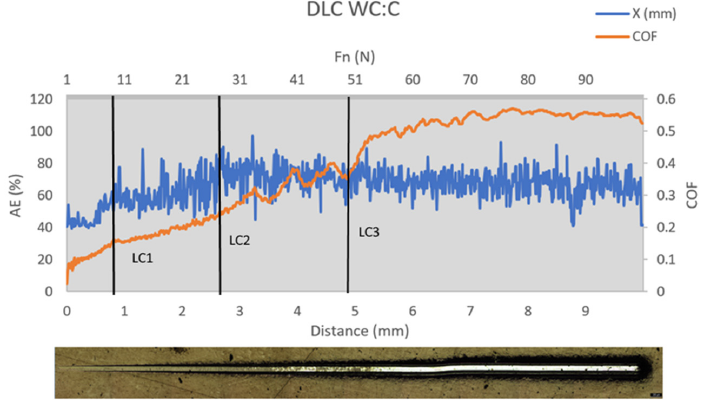
Figure 7. WC:C coating nano-scratch test: the COF (blue line) and acoustic emission (AE; orange line) evolution vs. the indenter displacement and an optical micrograph of the scratch tracks.